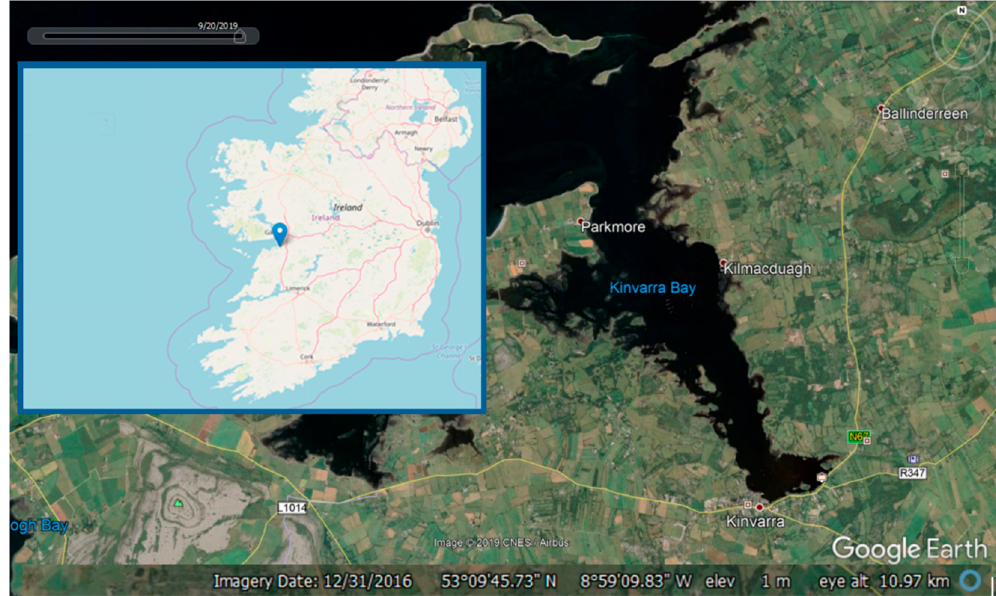
Figure 1. Kinvara Bay (adapted from Google Earth and Epsg.io source).